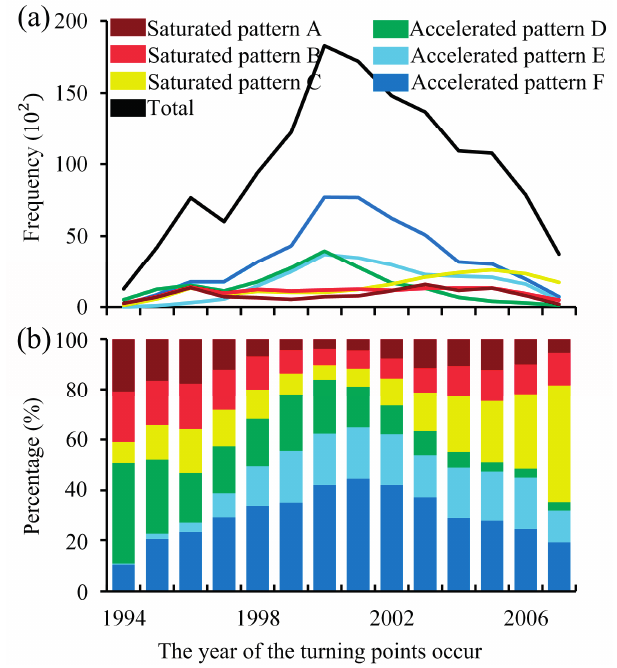
Figure 6. ( a ) Statistical distribution of six urbanization patterns in China from 1994 to 2007. ( b ) Percentage of six urbanization